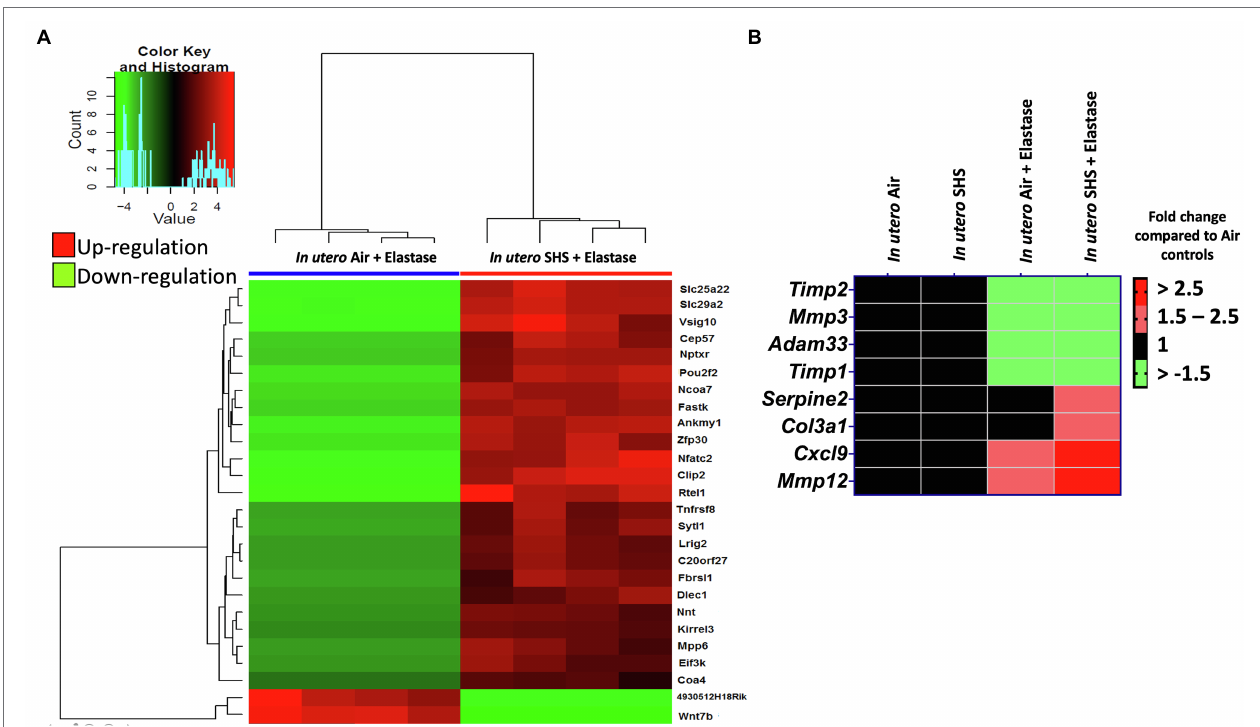
FIGURE 4 | In utero SHS plus adult elastase dysregulated lung gene expression. (A) Lung RNA sequencing results demonstrate that in utero SHS exposure plus elastase up-regulated 24 genes and down-regulated 2 genes when compared to the respective in utero air plus elastase control group at 15 weeks of age in female mouse offspring. N = 4 per group. Heatmap displays lung genes with a 2-fold up-/down-regulation ( p < 0.05) and a false discovery rate < 0.05. (B) Heatmap displays gene expression data obtained by qRT-PCR from the lungs of 15-week-old female mouse offspring. N = 4–5 per group. Data are expressed as mean per group. Genes displayed have fold-changes > ±1.5 up-/down-regulation compared to the in utero air plus saline control group and were considered significant.